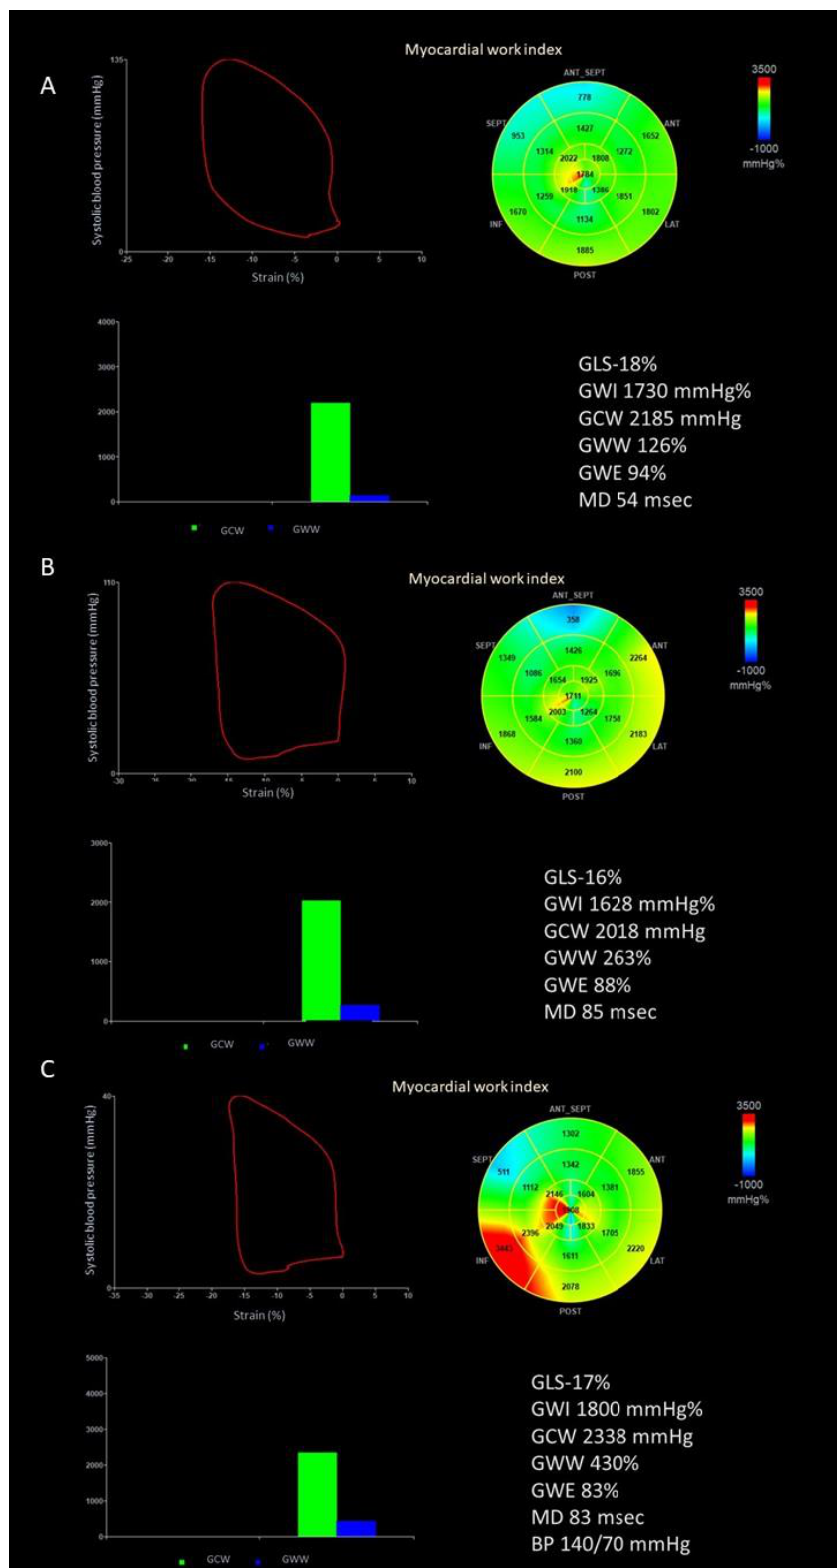
Figure 1. Example of the assessment of myocardial work indices. ( A ) Before transcatheter edge-to- edge repair of the mitral valve; ( B ) at hospital discharge; ( C ) at 1-year follow-up. BP, blood pressure; GLS, global longitudinal strain; GCW, global constructive work; GWE, global work efficiency; GWI, global work index; GWW, global wasted work; MD, mechanical